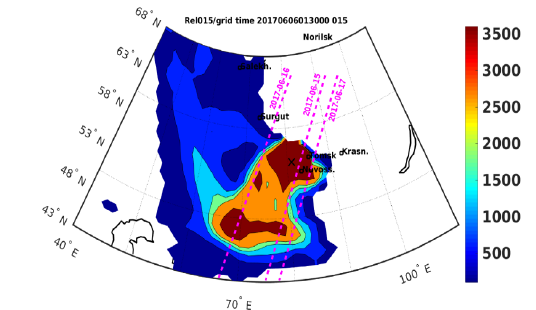
Fig. 3: Map of the PES distribution for FLEXPART backward simulation for the aerosol layers between 0-2 km at 56.6°N Fig. 2